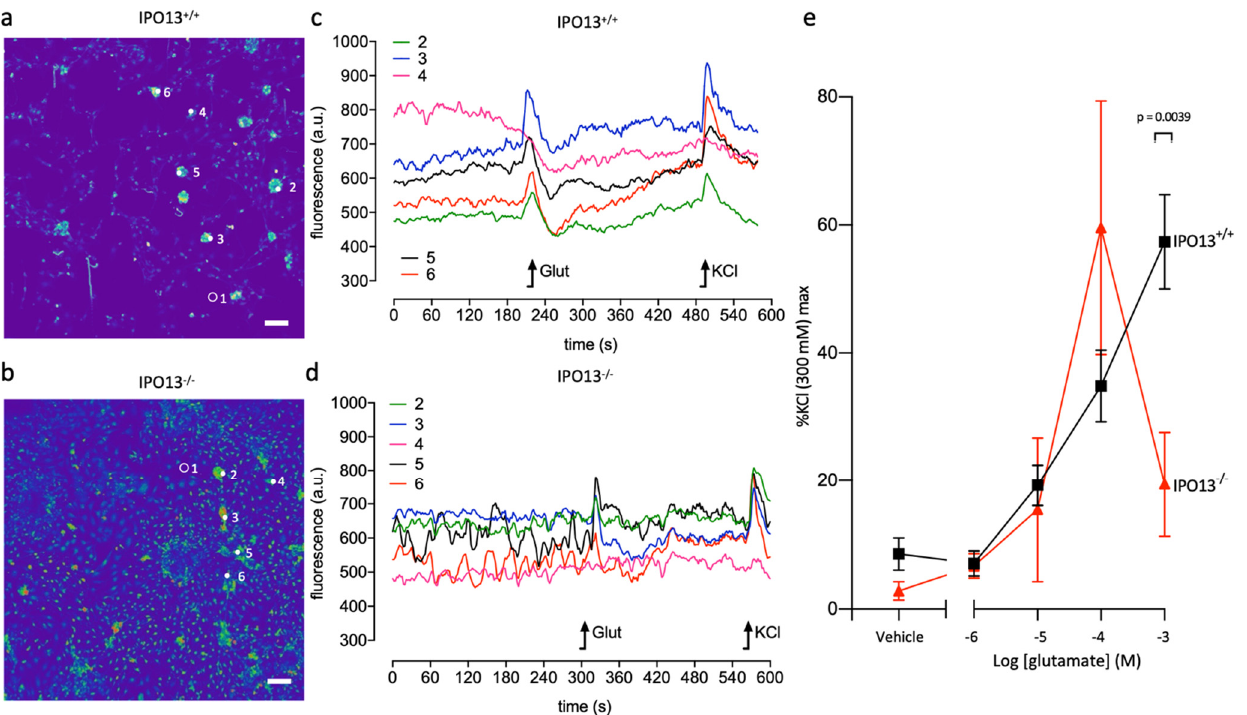
Figure 6. Absence of IPO13 impairs glutamate response in D14 cells. Ca 2+ imaging was employed to examine the functions of D14 IPO13 +/+ and IPO13 − / − cells. Cells were loaded with the Ca 2+ -sensitive probe Fluo-4 followed by stimulation with increasing concentrations of glutamate. ( a , b ). A typical field of view of IPO13 +/+ ( a ) or IPO13 − / − ( b ) D14 cells stimulated with 1000 µM of glutamate. Scale bar = 100 µm. Representative clusters measured for response to glutamate are circled and numbered (1 indicates a region for background subtraction). ( c , d ). Representative traces from the Ca 2 imaging experiment are shown for IPO13 +/+ ( c ) and IPO13 − / − ( d ) with oscillations resulting from glutamate and KCl indicated by a black arrow. Traces are numbered, corresponding to cell clusters in ( a , b , e ). Pooled data represent the mean ± SEM of three individual experiments ( n = 3) across which ≥ 5 randomly selected cell clusters (per n) were analysed. Statistical differences were determined by the unpaired t -test with Welch’s correction.